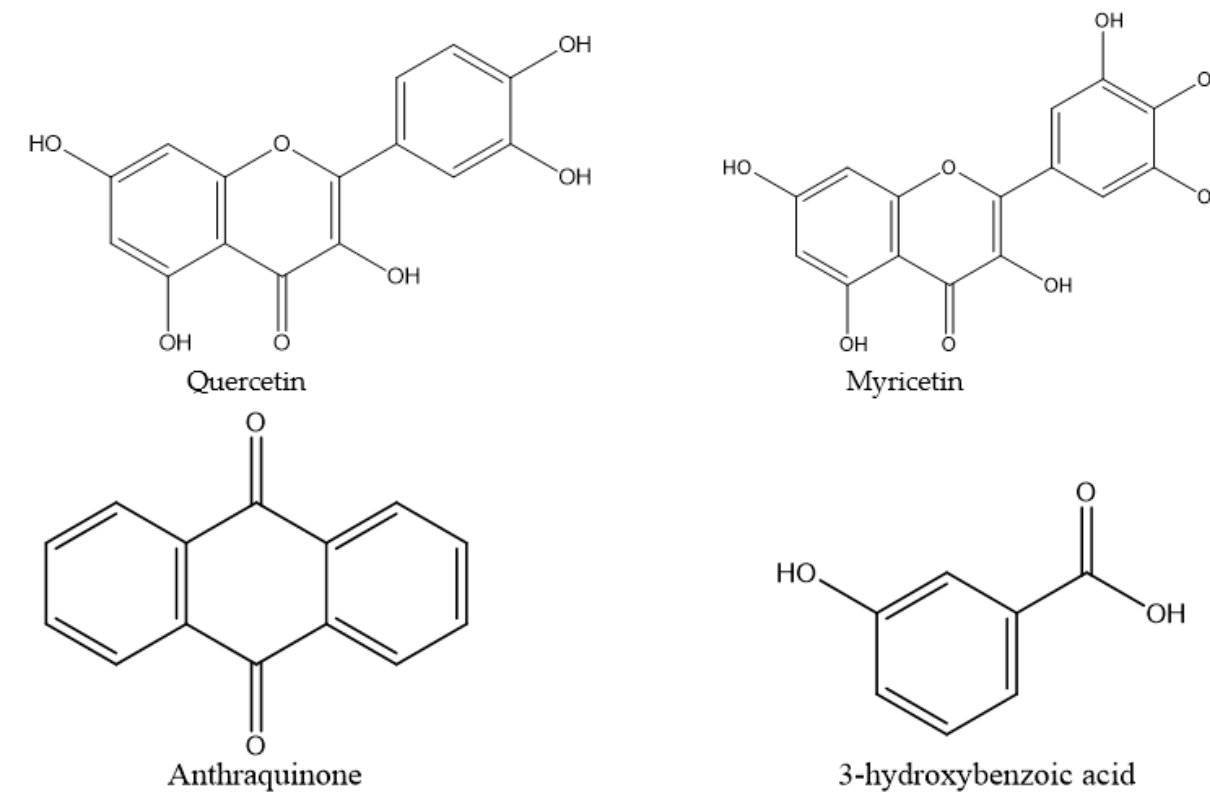
Figure 1. Chemical structure of the identified individual plant compounds. ChemDraw was used to generate the structure of the compounds based on their HPLC identification. The structure of astragaloside is not shown because it includes a group of compounds. Table 3. Ammonia nitrogen (NH 3 –N) concentration of the in vitro cultures after 24 h incubation. Plant Doses